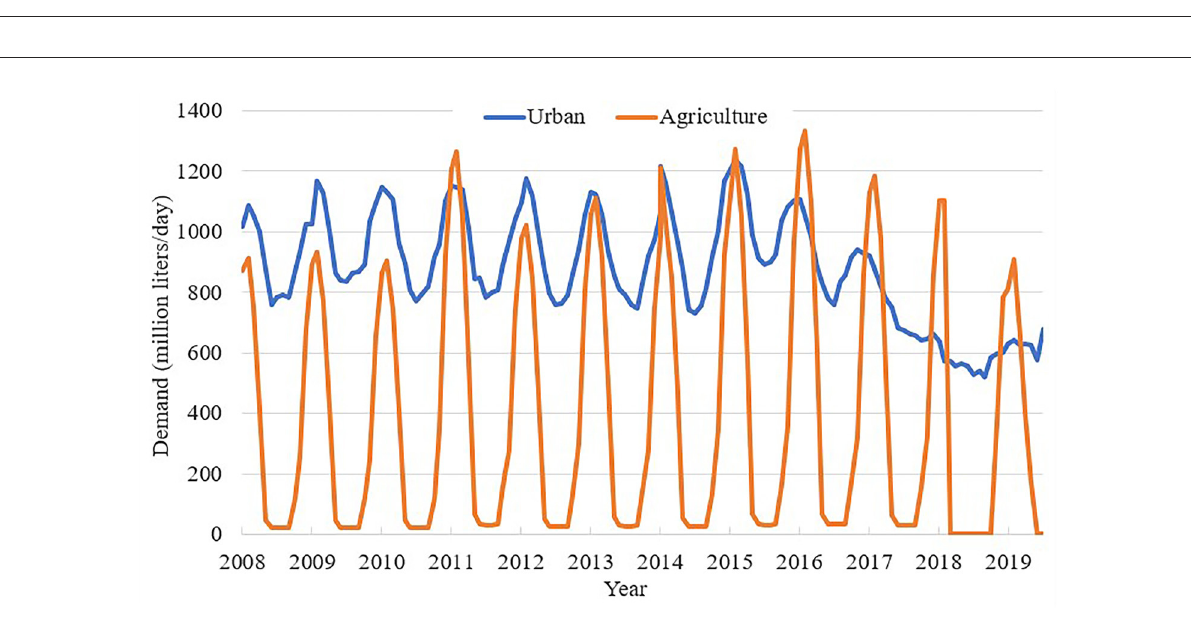
FIGURE5 Big Six-monthly rainfall and dam levels from 2008 to 2019 ( R 2 = 0.30 with a 3-month lag-time).